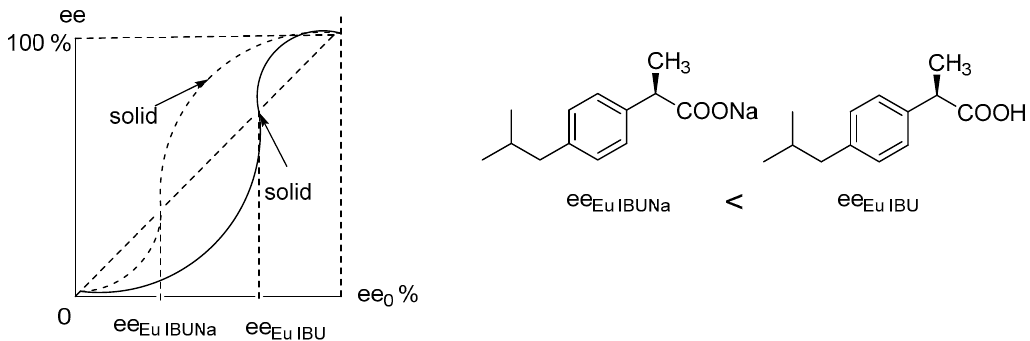
Figure 3. Phase diagram (ee 0 ‐ ee) of the enantiomeric mixture of ibuprofen and ibuprofen ‐ Na salt.